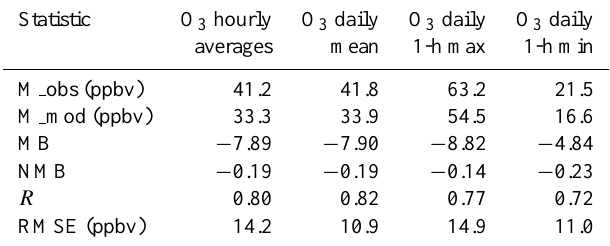
Table 2. Ozone statistics at all BAQS-Met surface mesonet stations, 2.5-km resolution simulations.